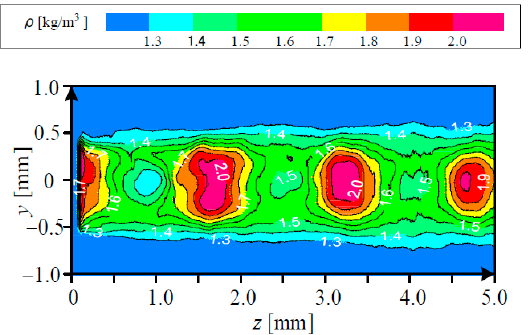
Figure 31. Rainbow Schlieren flow visualization. Reprinted with permission from Ref. [45] (2018).